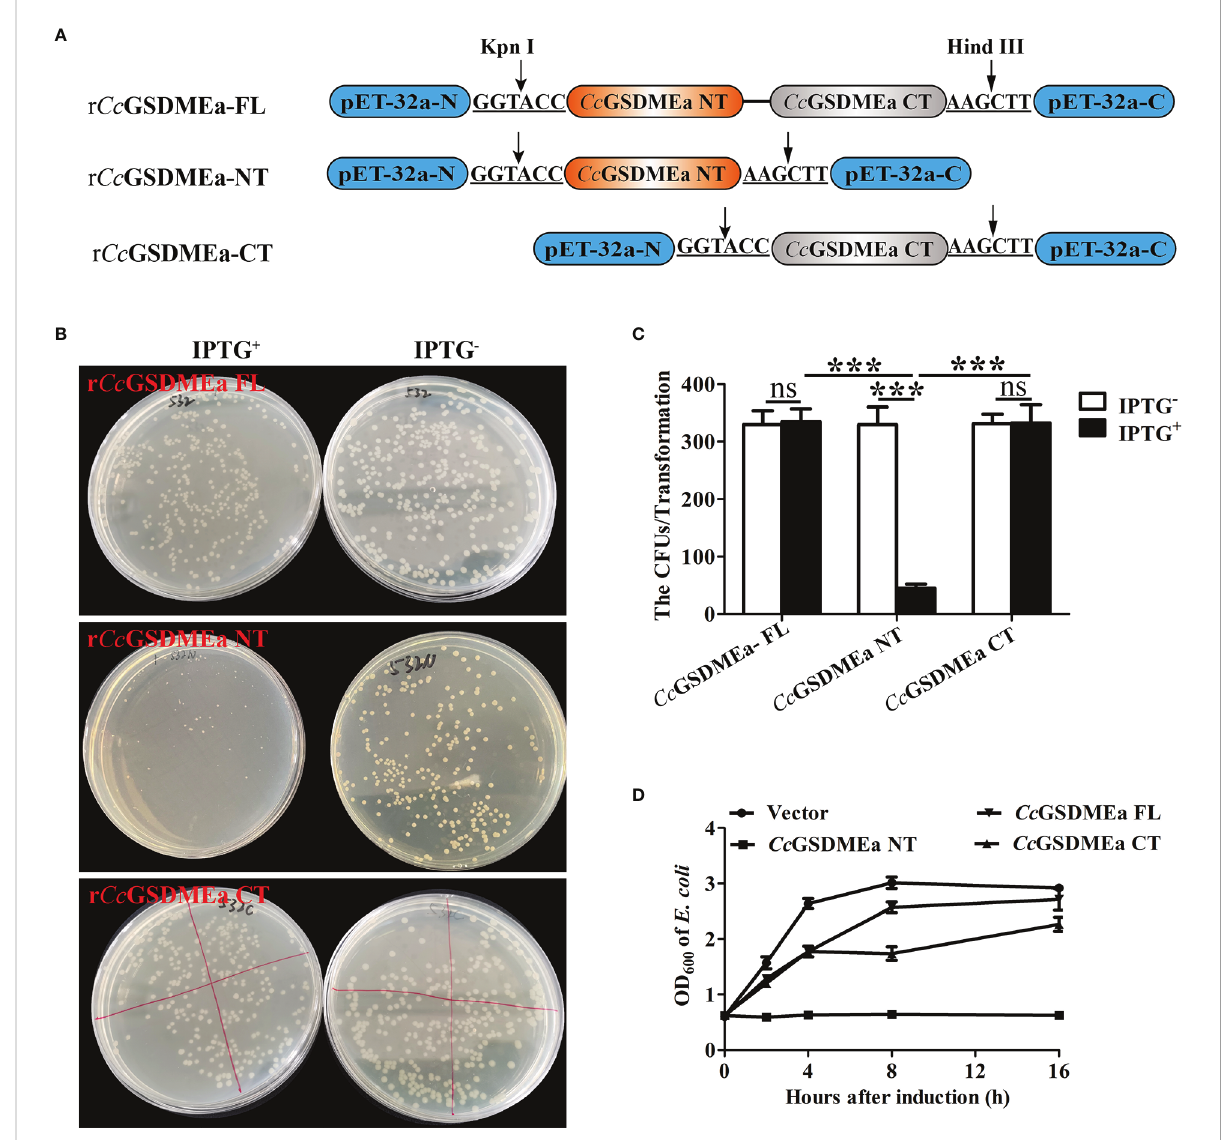
FIGURE 6 Bactericidal activity of Cc GSDMEa to E. coli . (A) Schematic diagram of the recombinant plasmids of r Cc GSDMEa-FL, r Cc GSDMEa-NT and r Cc GSDMEa-CT. (B) Colony growth of E. coli expressing r Cc GSDMEa-FL/NT/CT. (C) Calculation of CFUs on the plates. (D) Growth curves of E. coli expressing r Cc GSDMEa-FL/NT/CT after IPTG induction. Values are expressed as M ± SD (n = 3). The statistical difference was analyzed by student ’ s t test ( *** , P < 0.001; ns, no signi fi cant